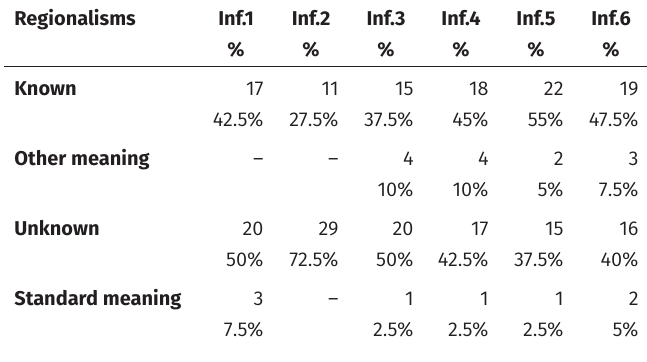
Table 5: Results from Ponta do Sol.